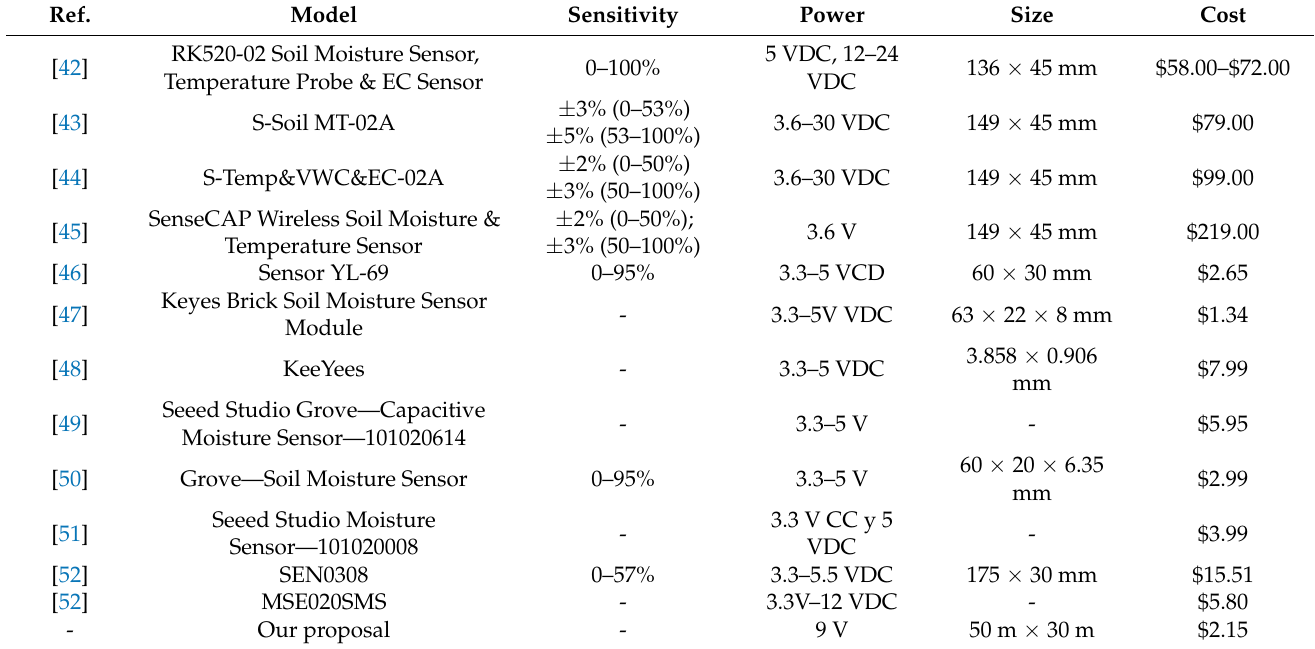
Table 5. Comparison of soil moisture sensors with our